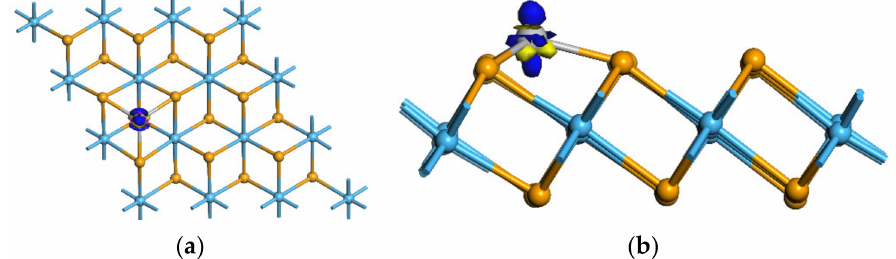
Figure 4. EDD of Ti − HfSe 2 with isosurface of 0.12e/Å 3 . ( a ) Top view; ( b ) front view.